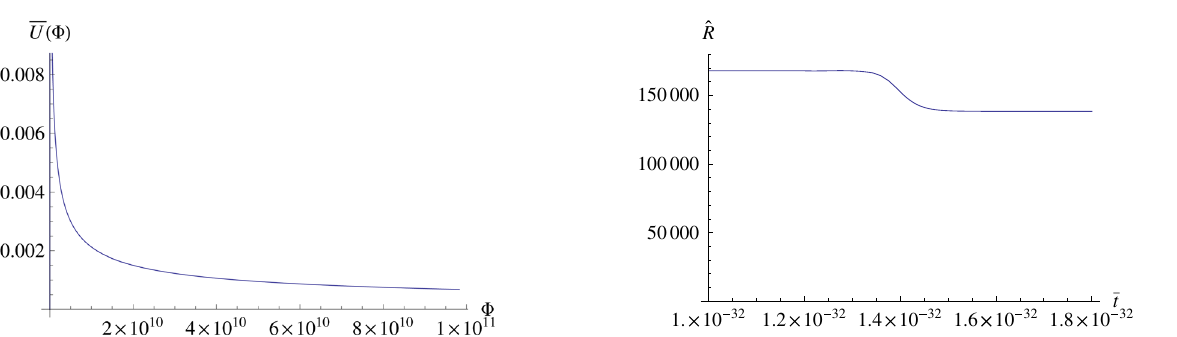
Fig. 6 The diagram presents the typical behaviour of the function ¯ U (Φ) for the case f ( ˆ R ) = ˆ R + γ ˆ R 2 + δ ˆ R 2 . The potential ¯ U (Φ) . Note that, for a large value of Φ , the function is expressed in km 2 s 2 Mpc 2 ¯ U (Φ) decreases asymptotically to zero